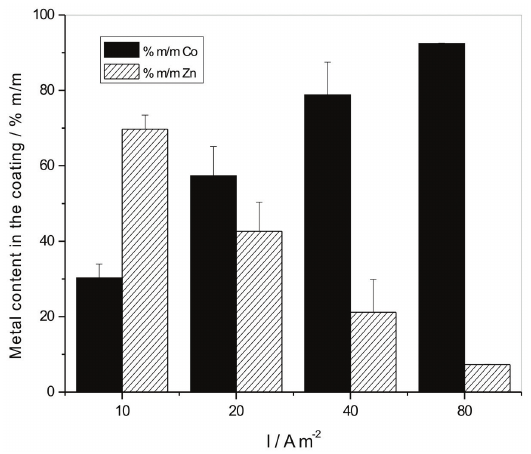
Figure 4. Average values of zinc and cobalt contents in the coatings ( % m/m Zn and % m/m Co ) produced at different values of I